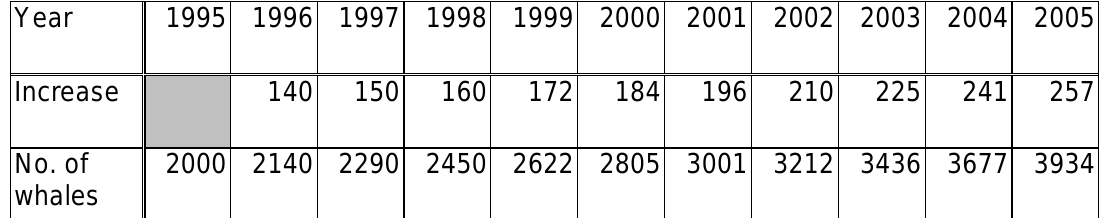
Table 8b. Completed table of